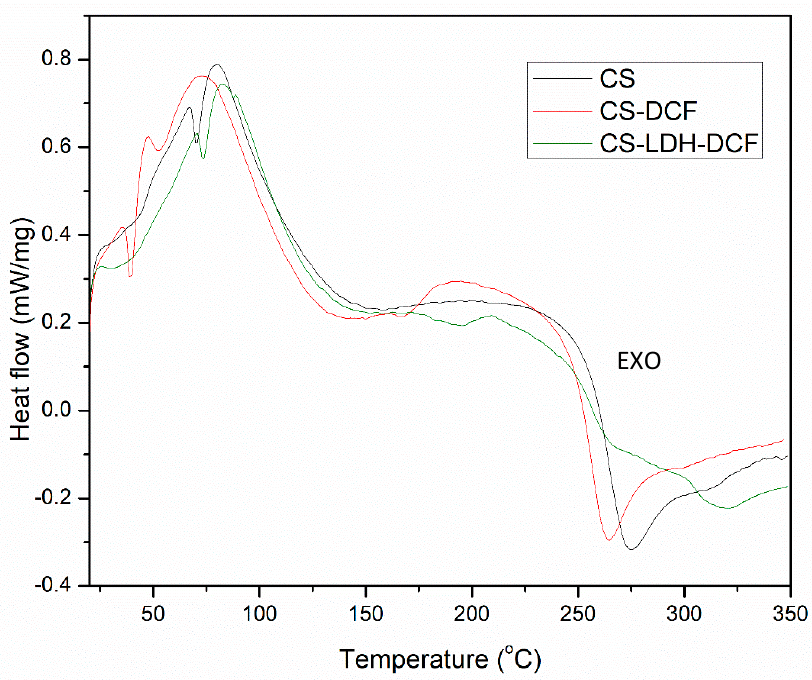
Figure 7. Differential scanning calorimetry (DSC) analysis of the neat CS, CS-DCF, and CS-LDH-DCF.